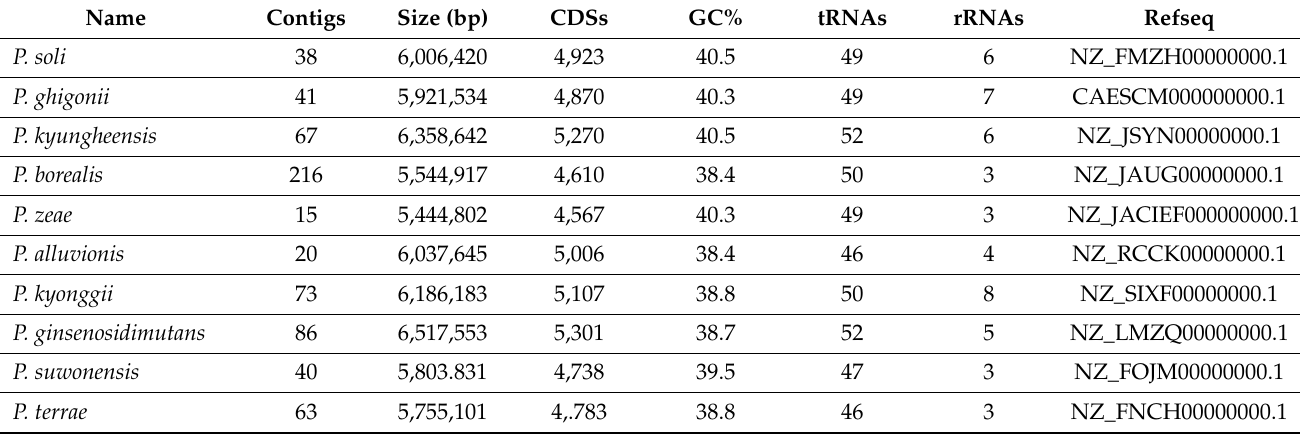
Table 3. Main genomic characteristics of the strain Marseille-Q2390 and other closely related Pedobacter species.